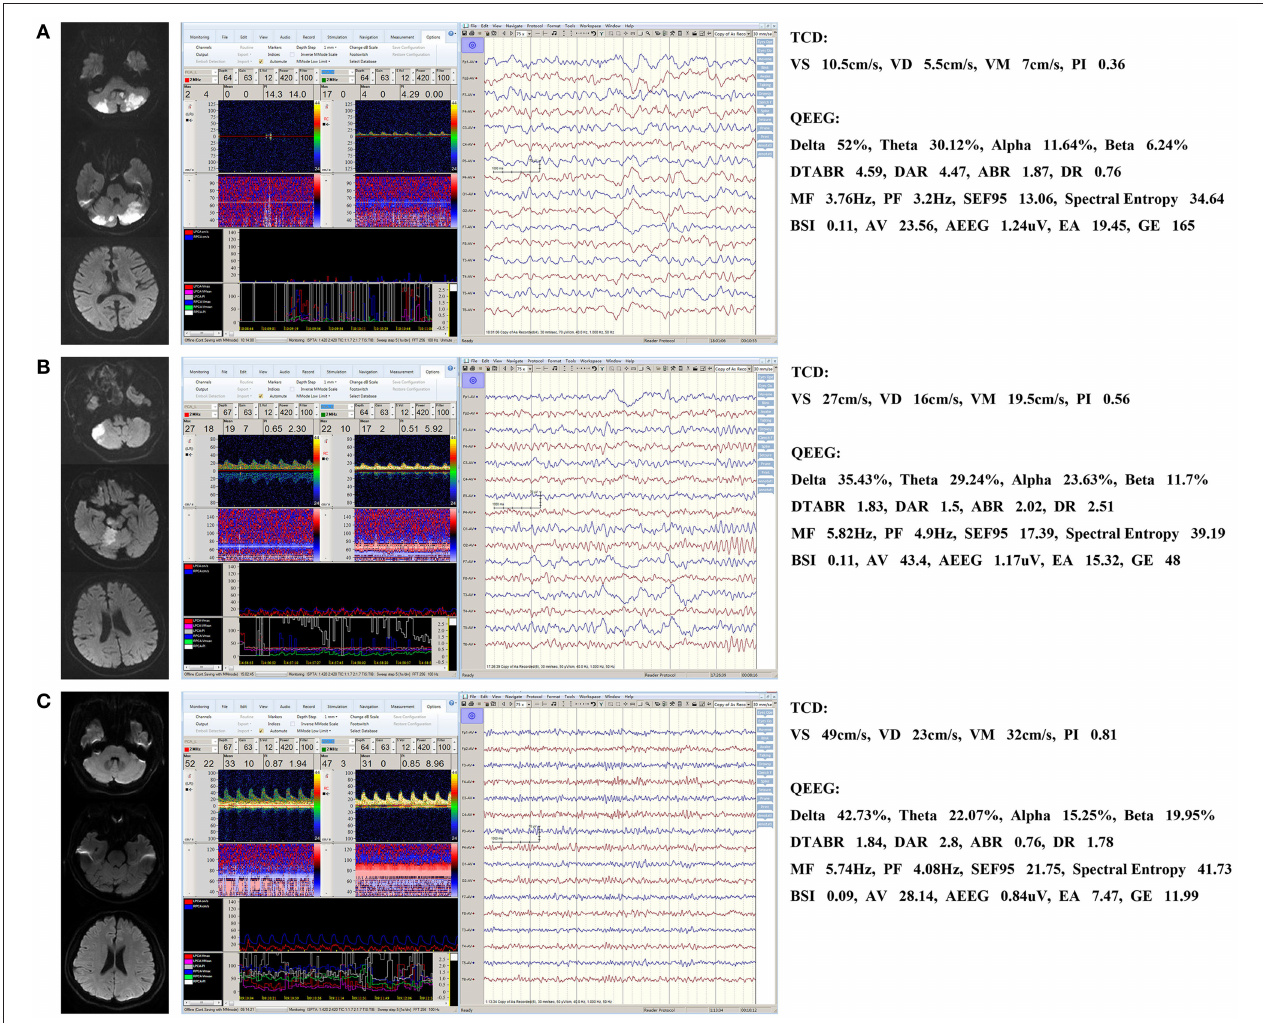
FIGURE 1 | Representative patients. (A) QEEG for a non-survivor showing a significant increase in the slower delta frequency band and a significant decrease in the faster alpha frequency band. MF and spectral entropy decreased and DTABR and DAR (but not BSI) increased. TCD shows that the VD, VS, and VM decreased. (B) QEEG and TCD for a survivor showing similar changes that are not as significant as those seen in a. BSI did not increase either. (C) Normal QEEG and TCD in a healthy control patient. DTABR, (delta + theta)/(alpha + beta) ratio; DAR, delta/alpha ratio; BSI, brain symmetry index; MF, median frequency; VS, systolic flow velocity; VM, mean flow velocity; VD, diastolic flow velocity; PI, pulsatility index; TCD, transcranial Doppler; QEEG, quantitative